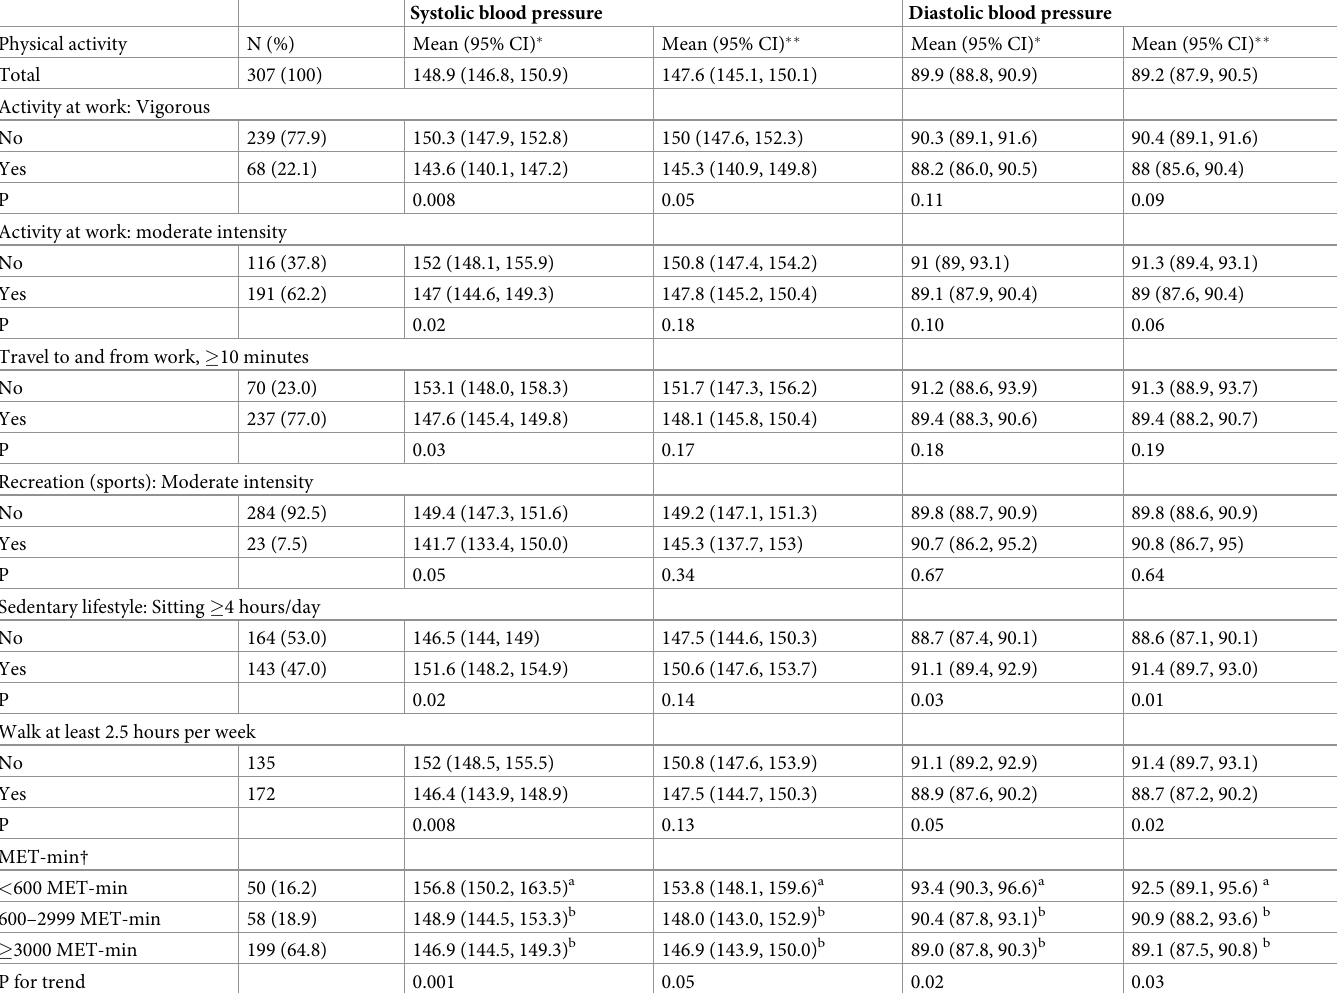
Table 2. Blood pressure by practice in taking part in physical activity at work, travel, recreation, and by sedentary lifestyle. Systolic blood pressure